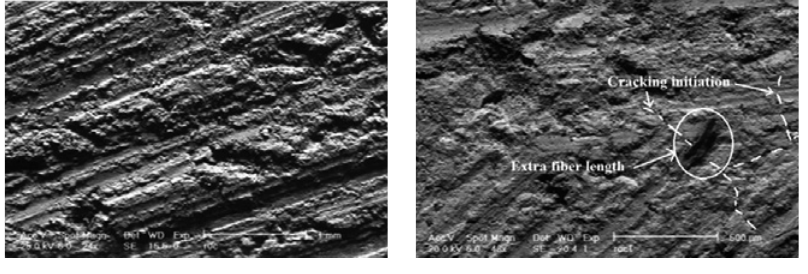
Figure 9. Scanning Electron Microscopy of